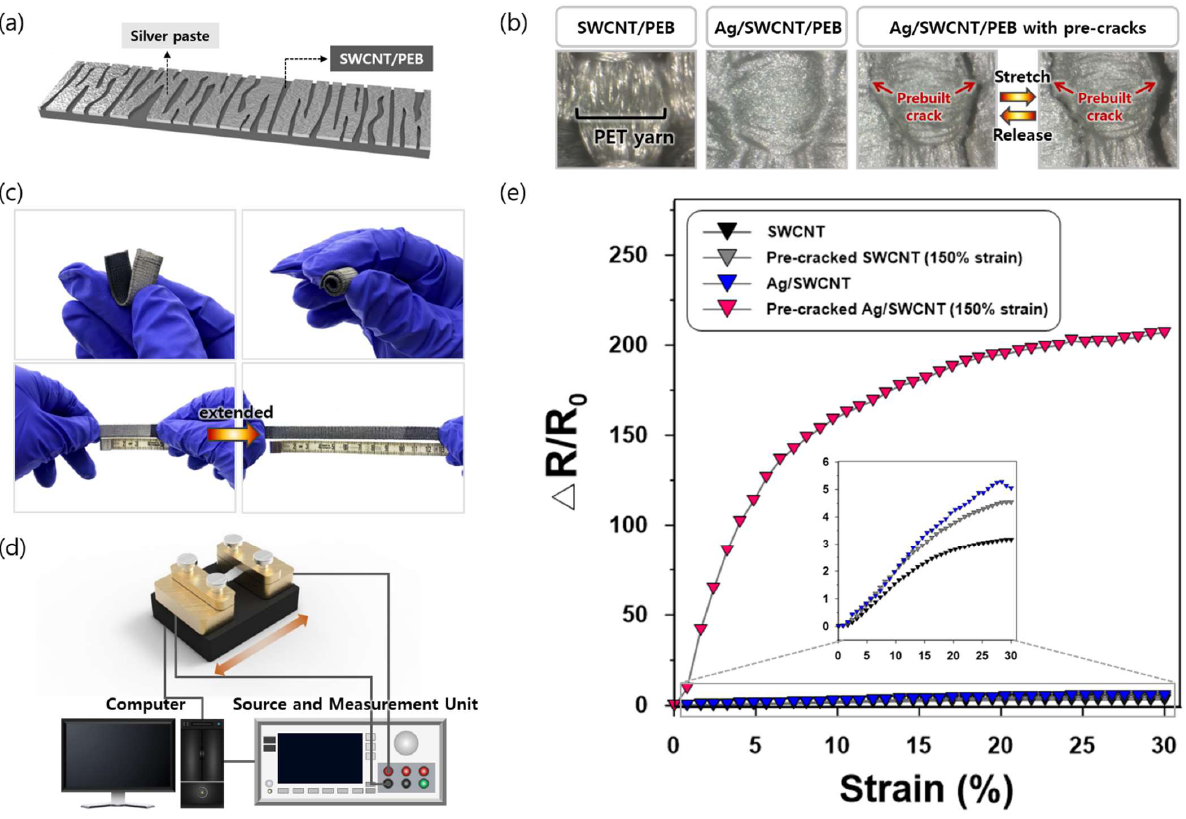
Figure 3. ( a ) Schematic structure of the pre-cracked strain sensor; ( b ) Pre-crack morphology of the pre-cracked strain sensor; ( c ) Flexibility of the pre-cracked strain sensor; ( d ) Customized Universal Testing Machine (UTM); ( e ) Relative changes in resistance versus strain of non-cracked SWCNT, pre-cracked SWCNT, non-cracked Ag/SWCNT, and pre-cracked Ag/SWCNT sensors.